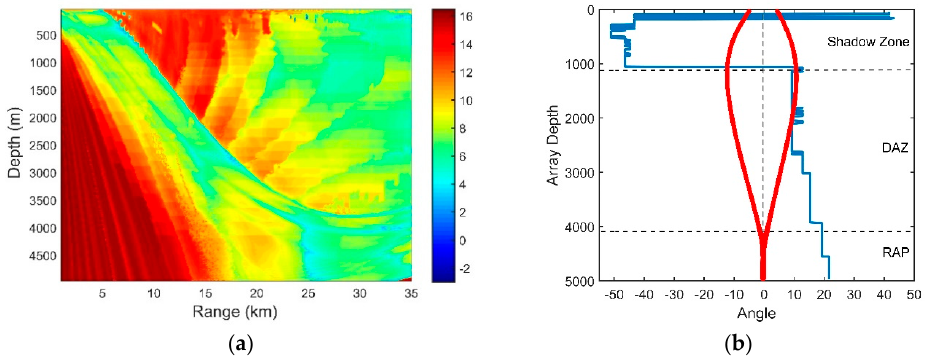
Figure 18. ( a ) OAG with different array locations; ( b ) Comparison of the directions of the signal and noise for all depths at a 10-km range. noise for all depths at a 10-km